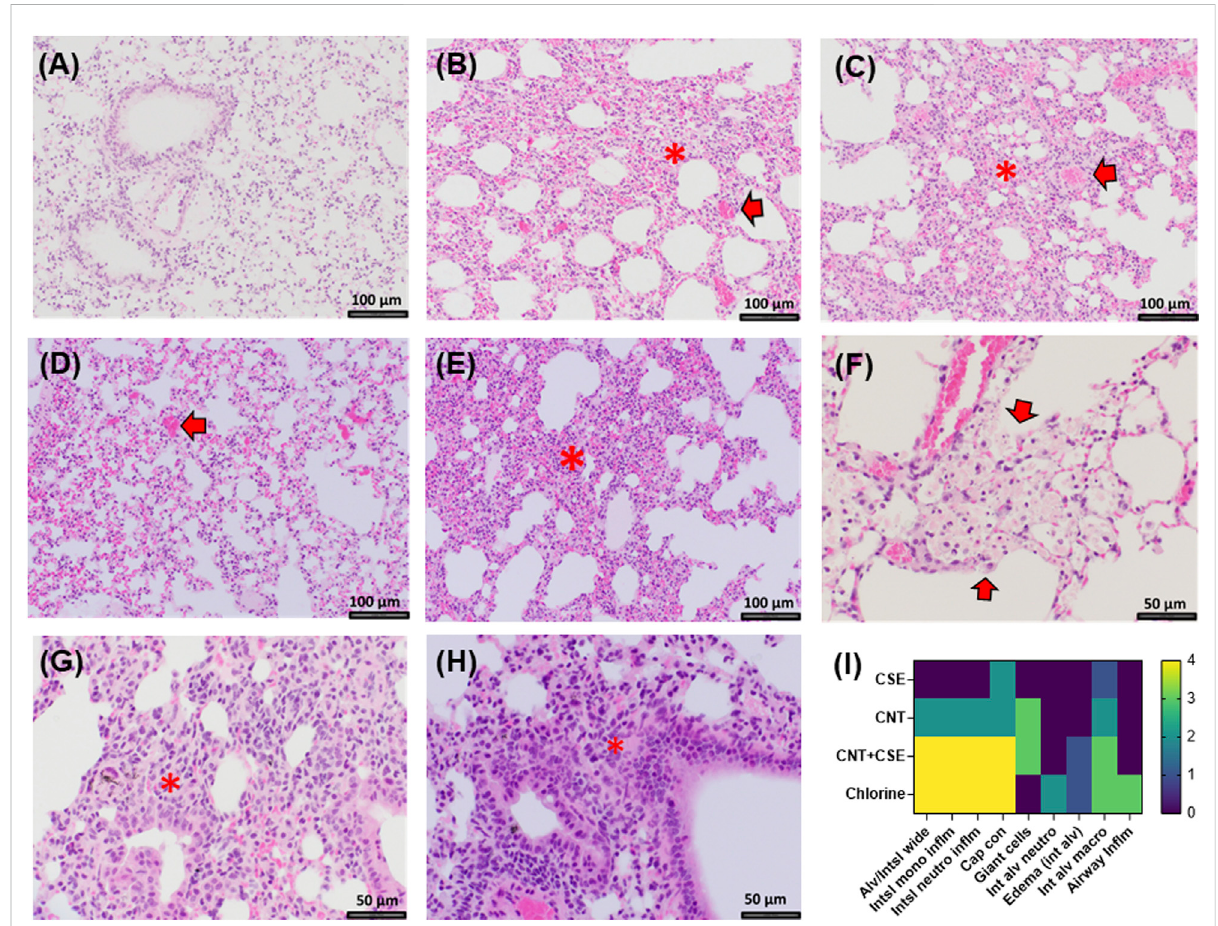
FIGURE 4 Histopathological changes in the lungs of mice exposed to different toxicants: (A). Control mice (×200 magni fi cation); (B). Mice exposed to Cl 2 showinginterstitialwidening(*)andcapillarycongestion(arrow,×200magni fi cation); (C). MiceexposedtoCNTshowingpatchyvascularcongestion (arrow) and interstitial widening (*, ×200 magni fi cation); (D). Mice exposed to CSE showing capillary congestion (arrow, ×200 magni fi cation); (E). CNT + CSE coexposed mice showing interstitial widening (*, ×200 magni fi cation); (F). Cl 2 exposed mice showing intra-alveolar foamy macrophages and debris material (arrows, ×400 magni fi cation); (G). Granulomatous reaction in CNT exposed lungs (*, ×400 magni fi cation); (H). Peribronchiolar granulomatous reaction in lungs coexposed to CNT and CSE (*, ×400 magni fi cation) (I). Heat map (scored as 0 to 4 on scale, with 0beingnormaland4 beingsevere) showingtheeffect ofdifferentexposures on differentimmuno-histologicalparameters. Abbreviations:Alveolar/ Interstitial widening (Alv/Intsl wide); Interstitial mononuclear in fl ammation (Int/mononu In fl m); Interstitial neutrophil in fl ammation (Int neut in fl m); Capillary congestion (Cap con); Giant cells, Intra-alveolar neutrophils (Int alv neutro); Intra-alveolar edema (edema int alv); Intra-alveolar Macrophages(Int alv macro); Airway in fl ammation (Airway in fl m). Magni fi cationscale is depictedwith asize-labelled baron individual images (A – H)